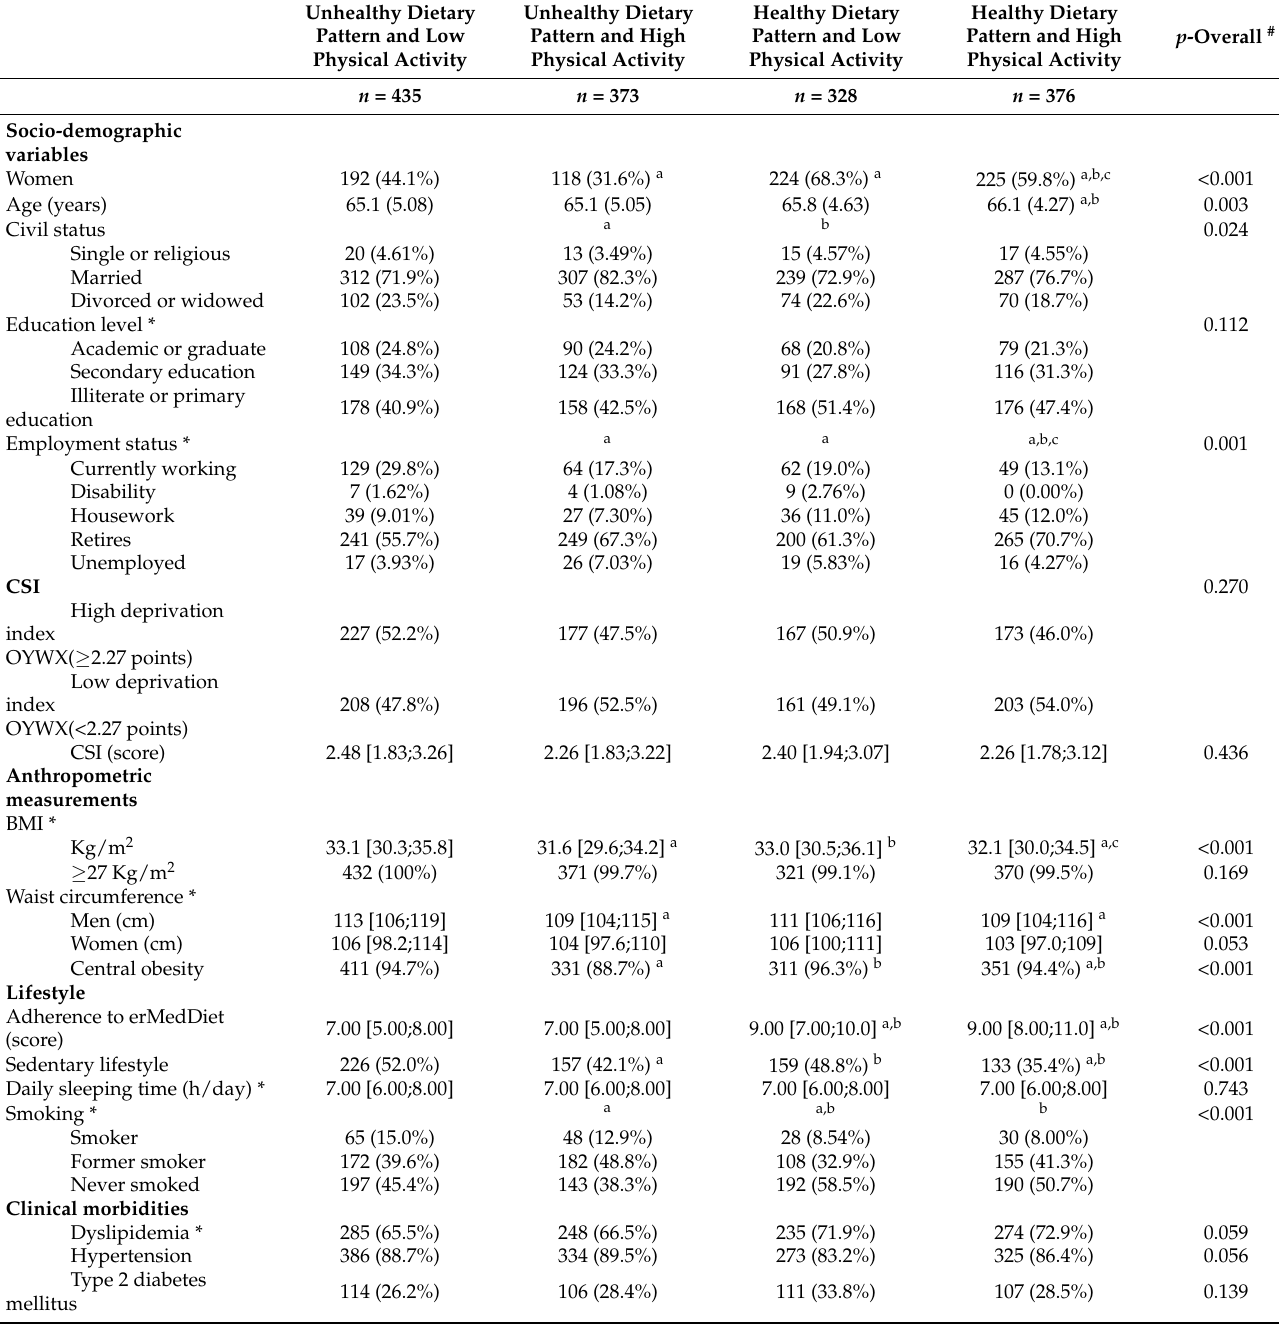
Table 3. General characteristics of the participants according to the lifestyle